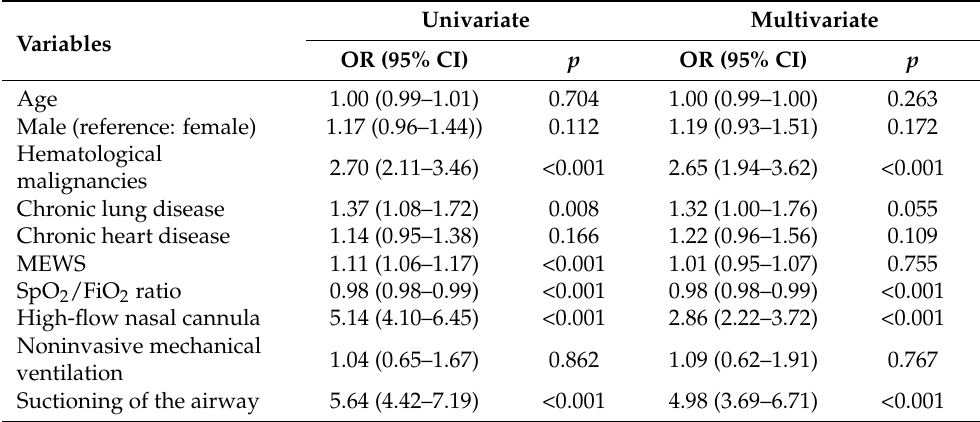
Table 5. Univariate and multivariate logistic regression analyses for repeat medical emergency team activation for respiratory